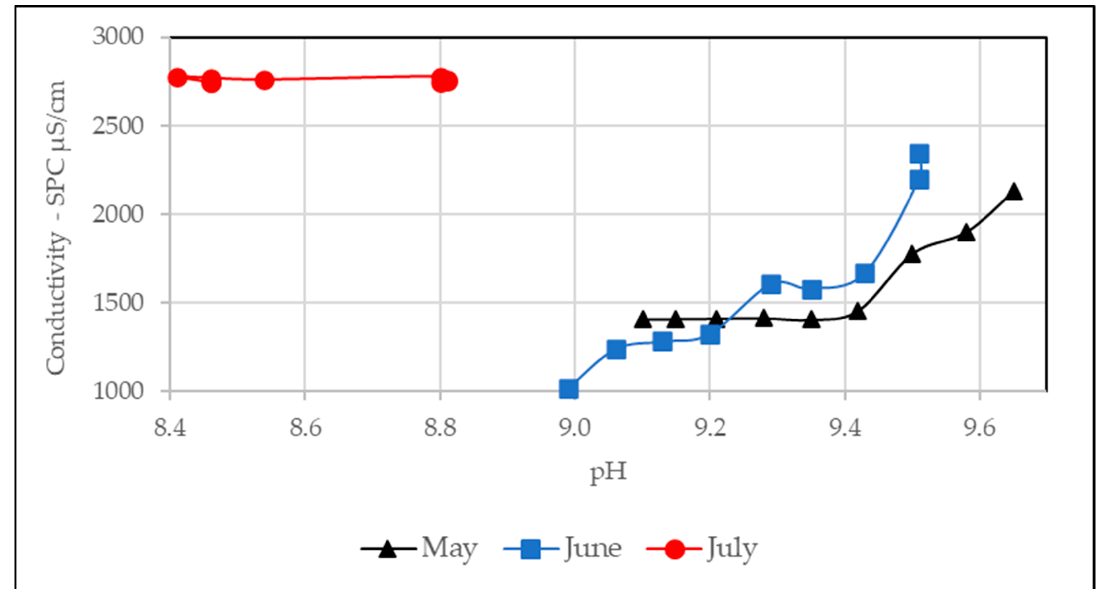
Figure 9. Effect of pH on SPC of nickel flotation feed.